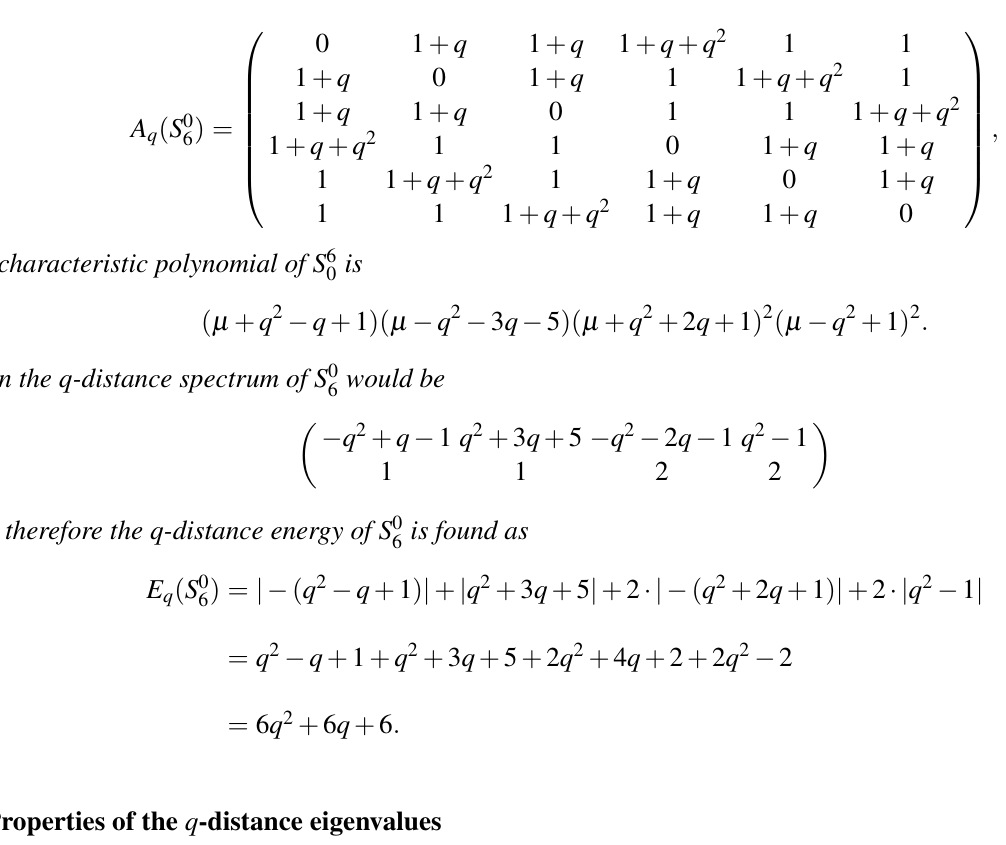
Figure 1.1 The crown graph S 6